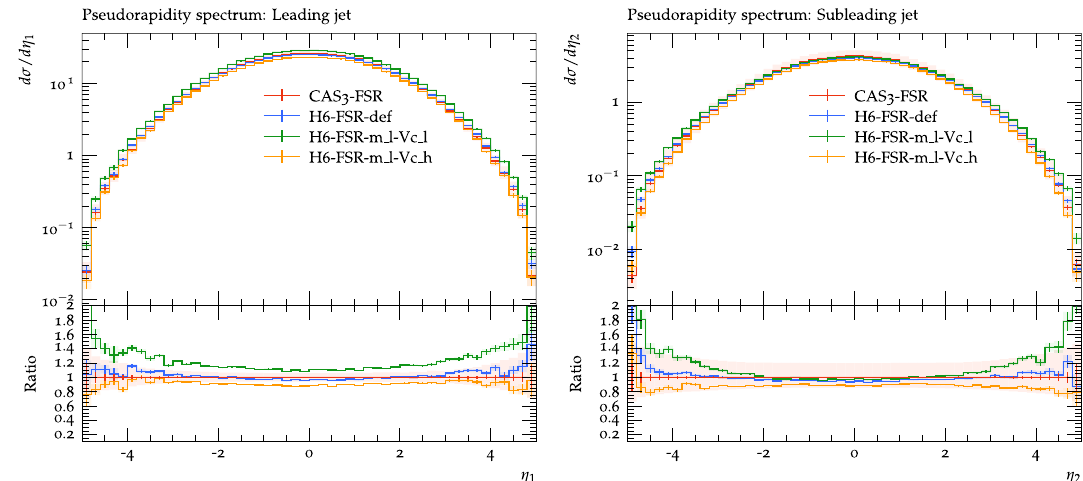
Fig. 8 Comparison of predictions obtained with MCatNLO+CAS3 and MCatNLO+H6 for Z + jet obtained with MCatNLO. Shown are predictions using only final state parton shower. The band of MCatNLO+CAS3 shows the uncertainties obtained from scale variation (as described in the text)